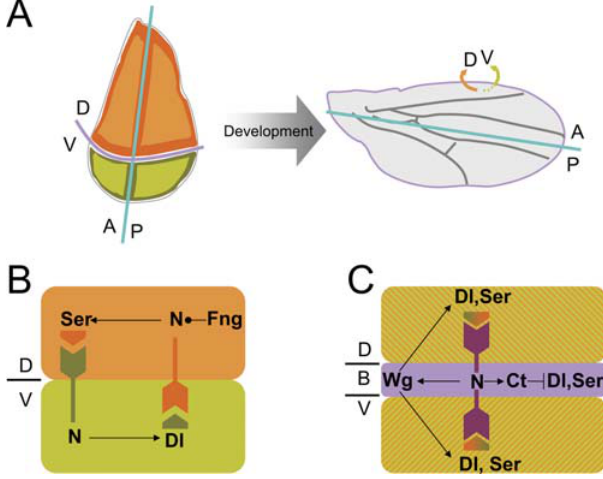
Figure 1. Gene regulatory network involved in DV boundary formation. (A) The wing primordium (left) is subdivided into anterior (A) and posterior (P) compartments, as well as into dorsal (D) and ventral (V) compartments, which will give rise to specific biological structures within the adult wing (right). The compartments are named after the position that their cells and progeny will occupy by the end of development. (B, C) Early in development (B), Serrate (Ser) signals to V cells to activate Notch (N). Likewise, Delta (Dl) signals to D cells to activate Notch modified by Fringe (Fng) along the DV boundary. Later in development (C), ligands expression becomes symmetric with respect to the boundary and a positive feedback-loop between Wingless (Wg) and Ser/Dl-expressing cells maintains the signaling center along the DV boundary. Notch activity elicits Cut expression that represses Dl and Ser in boundary cells.